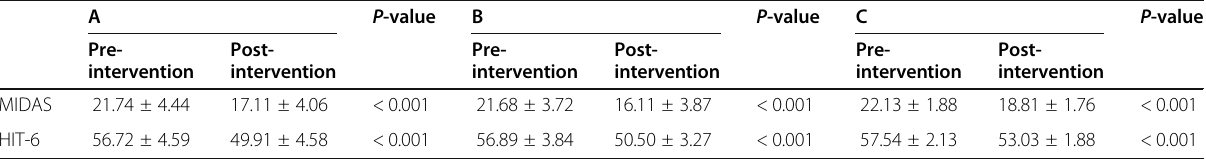
Table 3 Analysis of MIDAS and HIT score in a different group (A: Sodium Valproate; B: Sodium Valproate +Magnesium; C: Magnesium) compared to